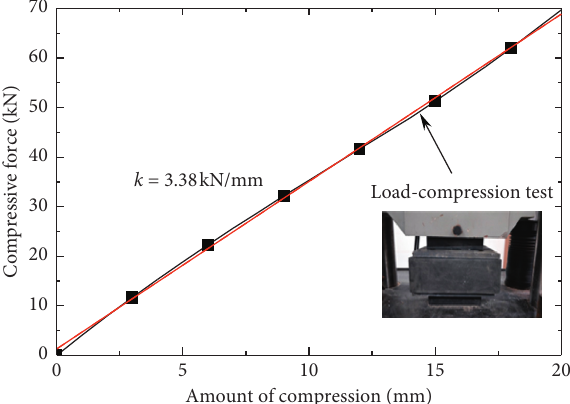
Figure 3: Compression-deformation curves of a rubber